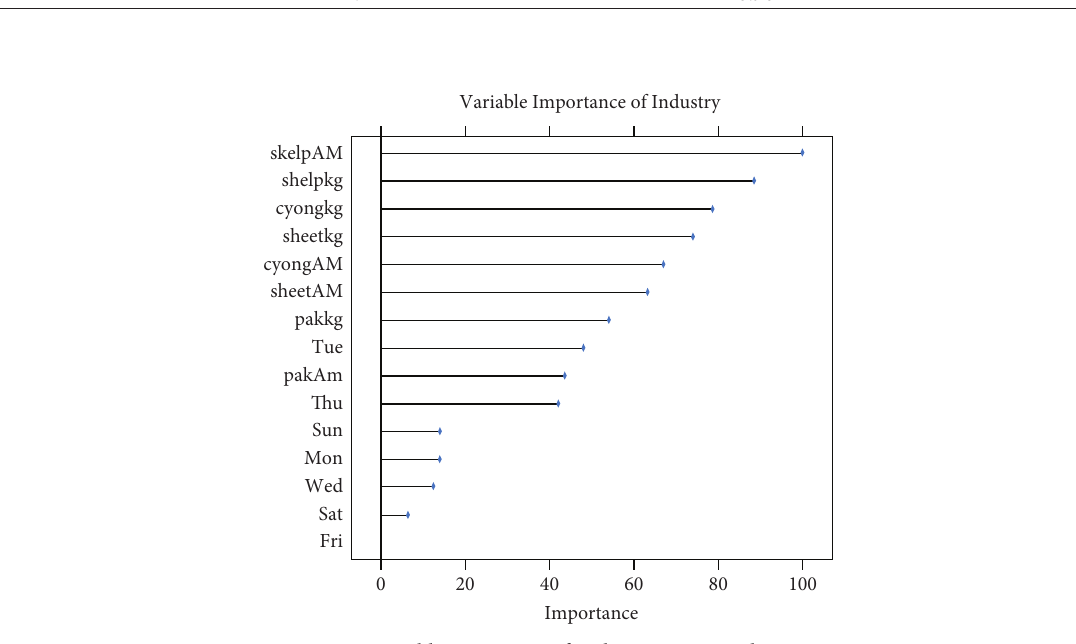
Figure 20: Variable importance for the Daewoo Steel Factory.